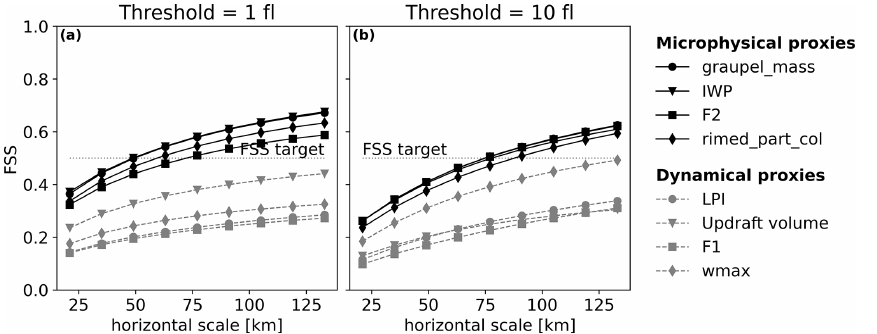
Figure 11. Mean FSS of the whole validation period for all the proxies for (a) 1-flash threshold and (b) 10-flash threshold for RF20- based